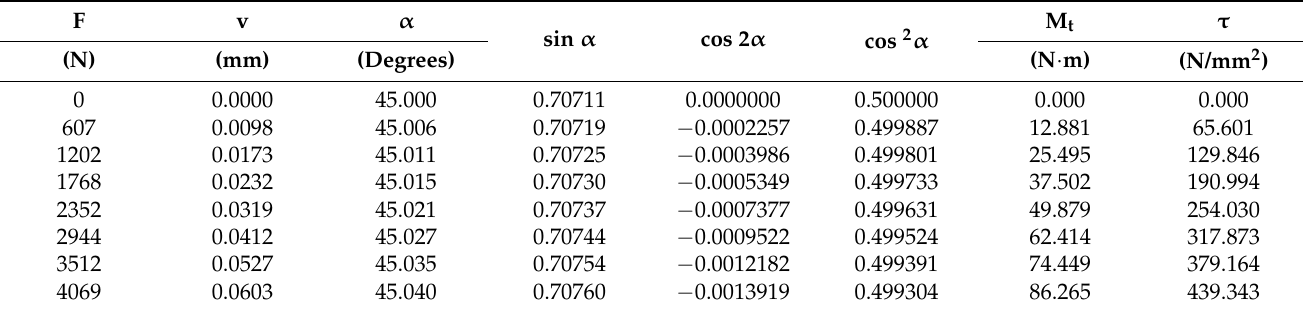
Table 1. Results obtained for the determination of Mt based on F and v.